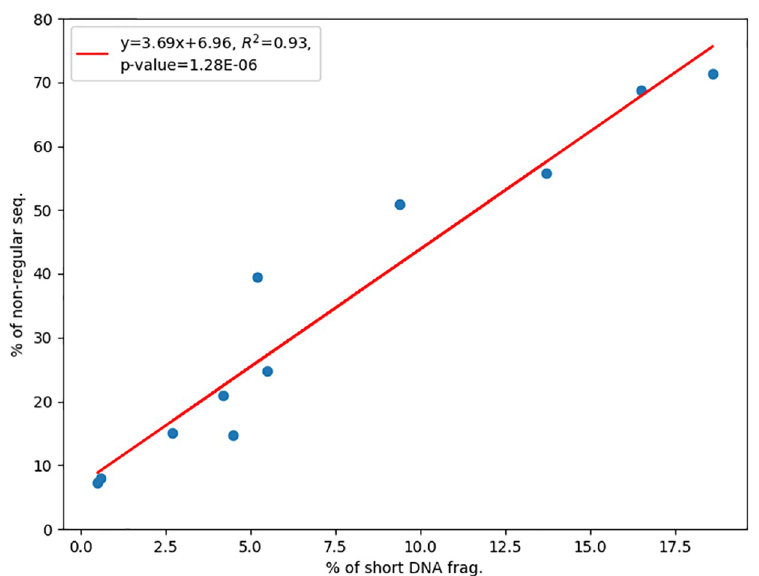
Fig 4. Correlation between the fraction of non-regular TCR- β sequences in the 5’-RACE data and the fraction of short DNA fragments in the library.